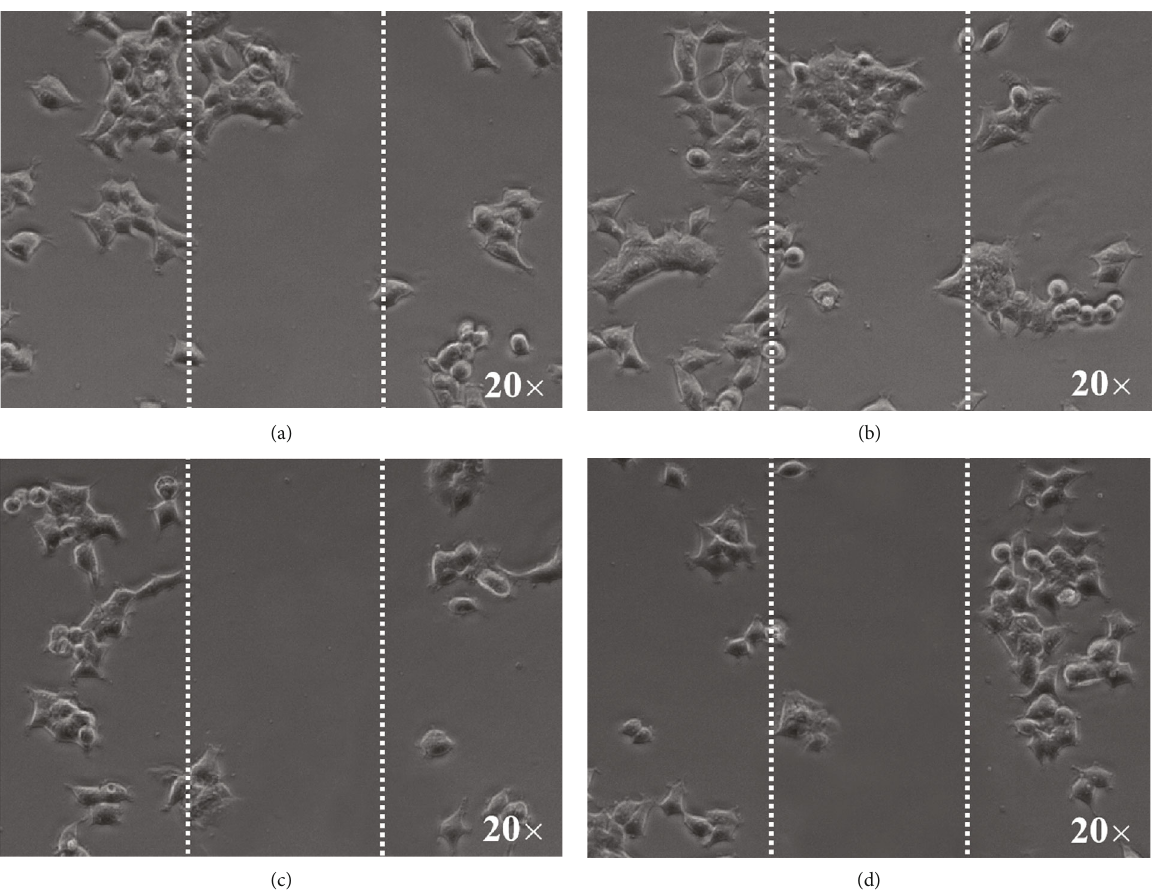
Figure 5: Scratch test of CAL-27 cells after chemotherapy. (a) CAL-27 cells without any treatment, 20x; (b) CAL-27 cells with ULK1 silence- expression, 20x; (c) CAL-27 cells with ULK1 overexpression, 20x. (d) CAL-27 cells with miR-214 overexpression and ULK1 silence- expression,